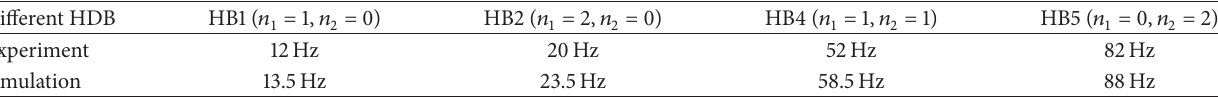
Table 3: Comparison of the liquid column resonance